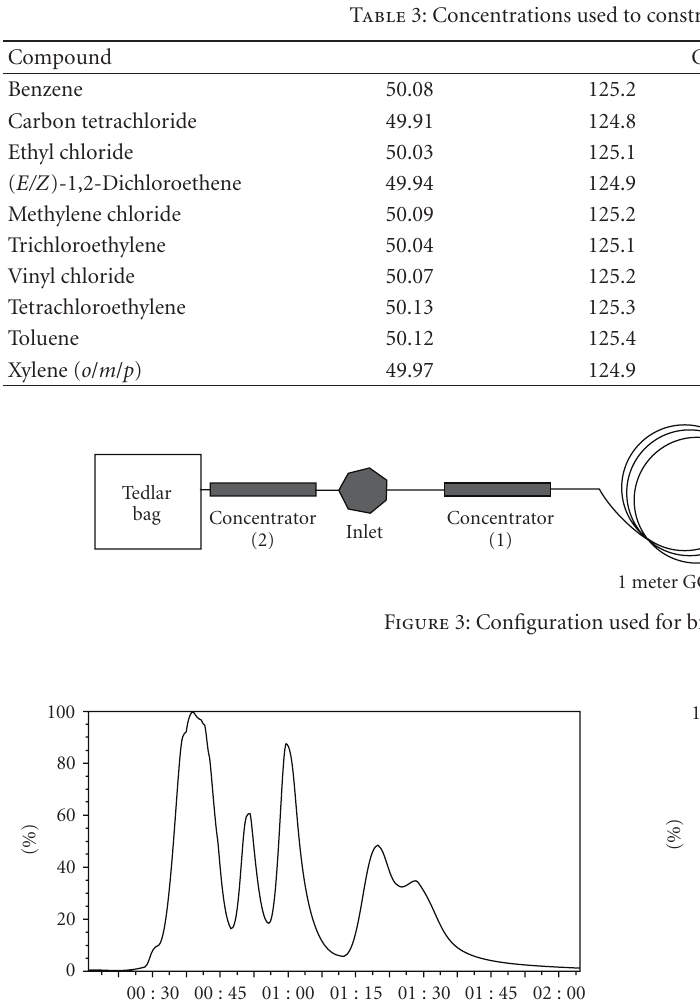
Figure 5: Reconstructed ion chromatogram (RIC) from the TIC illustrated in Figure